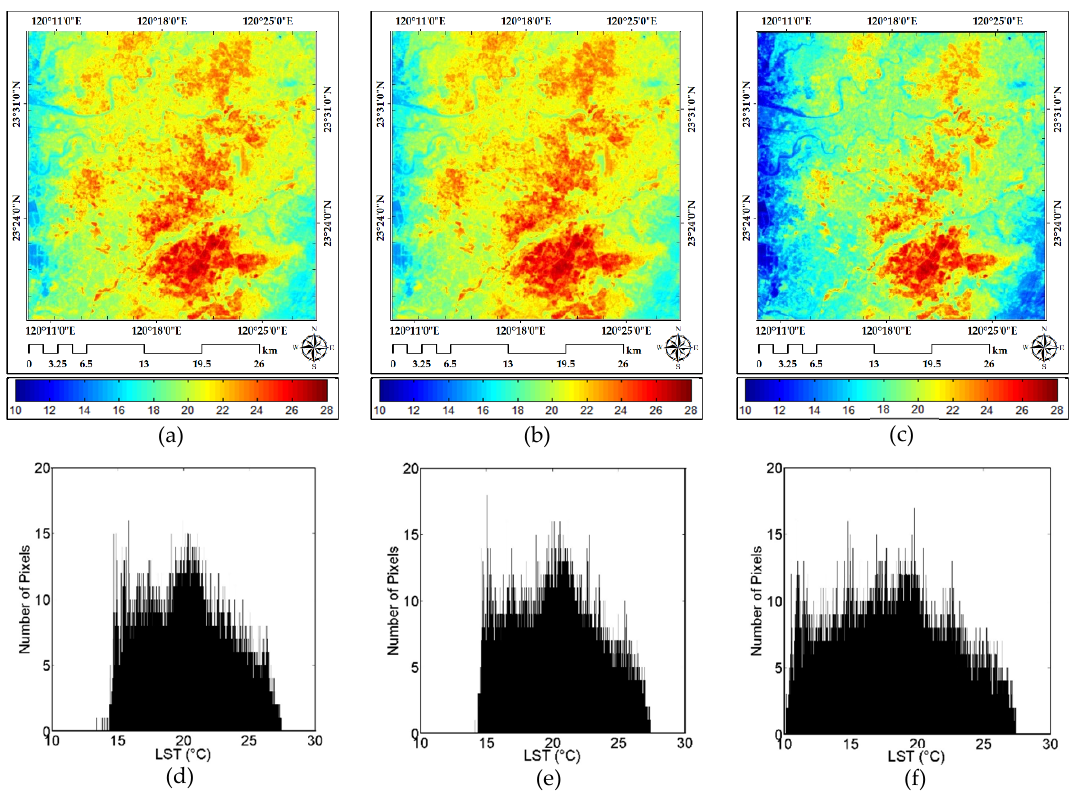
Figure 8. Hourly LST images (°C) estimated from STAEFM TIR on 18 January 2019 at ( a ) 09:00–10:00,